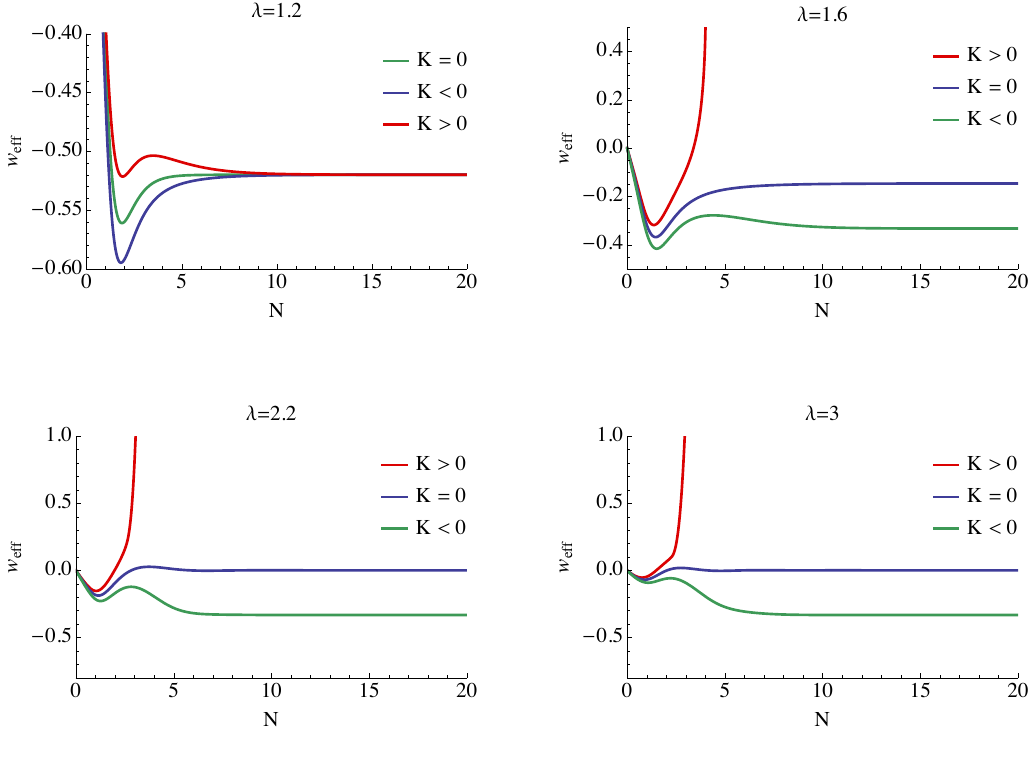
Figure 3. Evolution of equation-of-state parameter over 20 e-foldings (N) for four different cases of λ